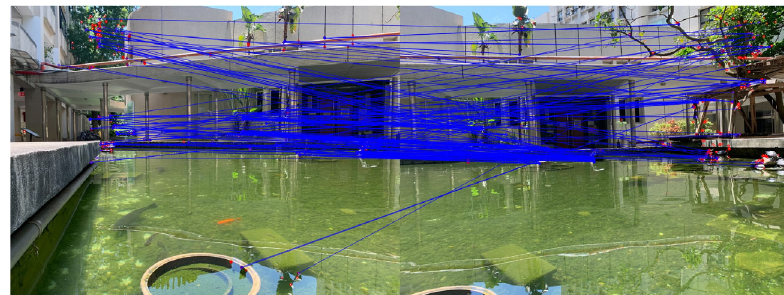
Figure 16. Feature points matched.